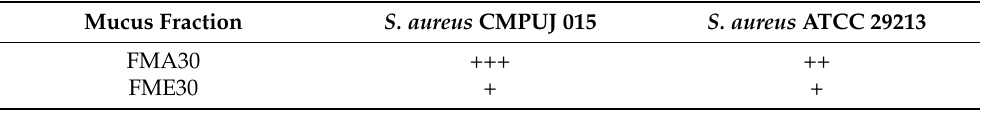
Table 4. Inhibition of the coagulase production of S. aureus strains. Mucus